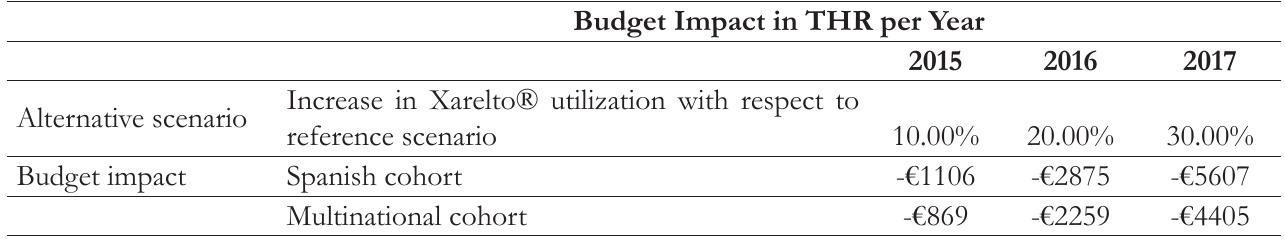
Table 5. Increasing Budget Impact when increasing Rivaroxaban Utilization by Year in THR Patients in Spain